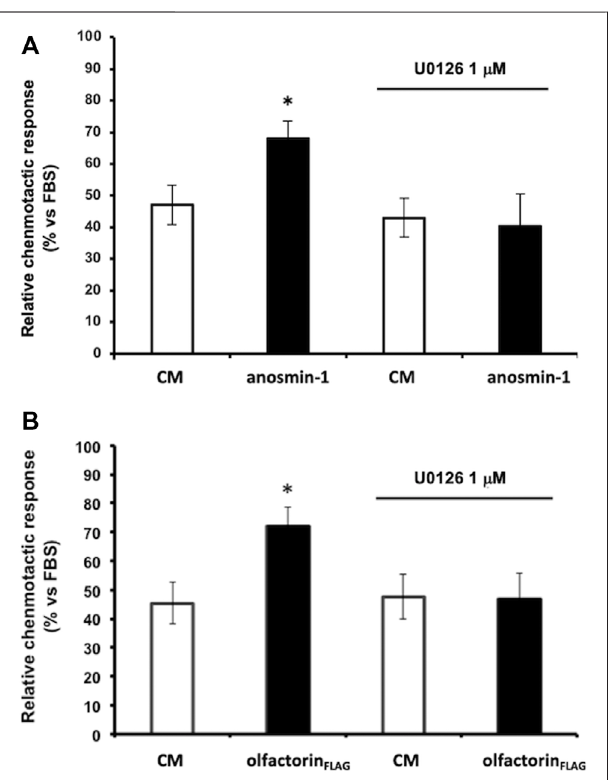
FIGURE 4 | Effect of the ERK1/2 signaling pathway inhibitor on anaosmin-1- and olfactorin FLAG -induced GN11 chemomigration. GN11 cells were pretreated with ERK1/2 inhibitor U0126 (1 µM) and then to the exposed controlCM,anosmin-1 (A) orolfactorin FLAG (B) .Theresults(mean ±SD; n. 4) are expressed as the relative chemotactic response of GN11 cells with respect to the stimulus exerted by 0.1% FBS. * p < 0.05 vs. respective